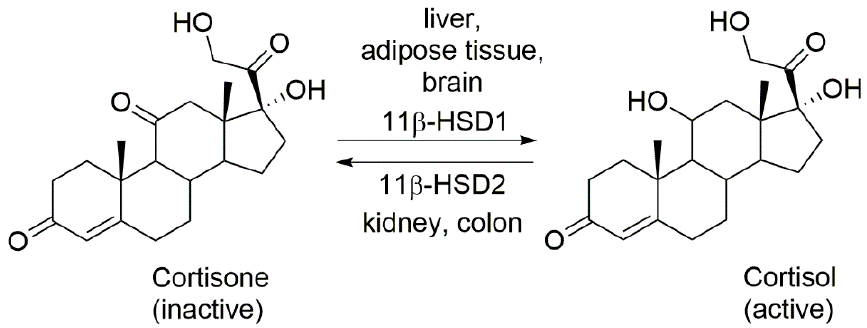
Figure 1. The physiological role of the two isoenzymes: 11 β -HSD1 and 11 β -HSD2 [9]. 11 β -HSD1 is a product of the HSD11B1 gene, which is located on chromosome 1 in humans and rodents. 11 β -HSD1 catalyzes the interconversion of cortisone to cortisol. In turn, 11 β -HSD2 is encoded by a gene that is located on chromosome 16 in humans and on chromosome 8 in rodents, respectively. Both types of 11 β -hydroxysteroid dehydrogenase are microsomal enzymes that are associated with the cell membrane of the